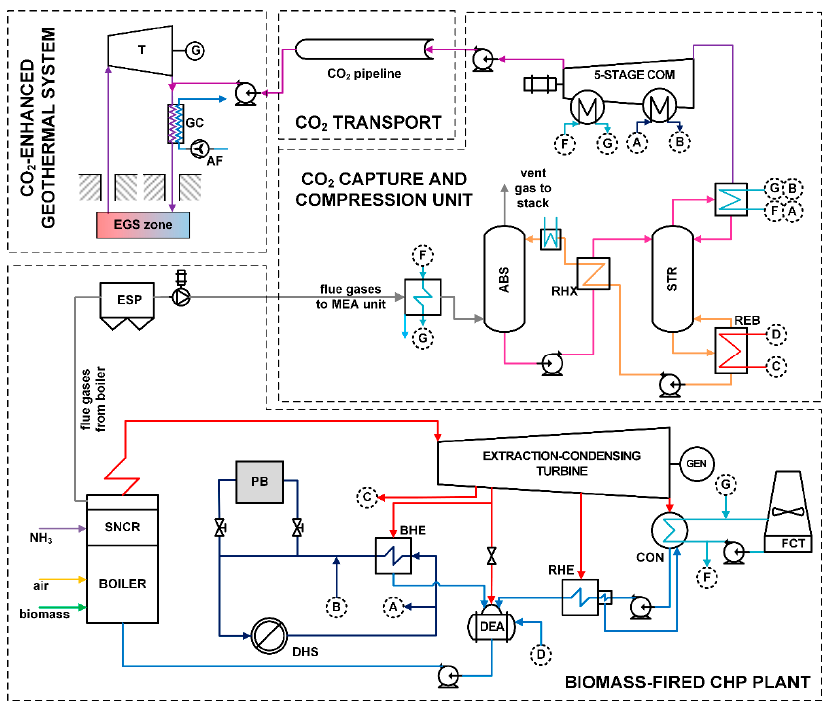
Figure 5. Simplified diagram of a CHP unit with an extraction-condensing turbine, a CO 2 capture and compression unit, and a CO 2 -enhanced geothermal system with a supercritical CO 2 (sCO 2 ) Brayton cycle (T: turbine; GC: gas cooler; AF: air fan; G: generator; COM: compressor; REB: reboiler; STR: stripper; ABS: absorber; ESP: electrostatic precipitator; BHE: base heat exchanger; RHE: regenerative heat exchanger; FCT: force-draft cooling tower; CON: condenser; DEA: deaerator; PB: peak boiler; SNCR: elective non-catalytic reduction).